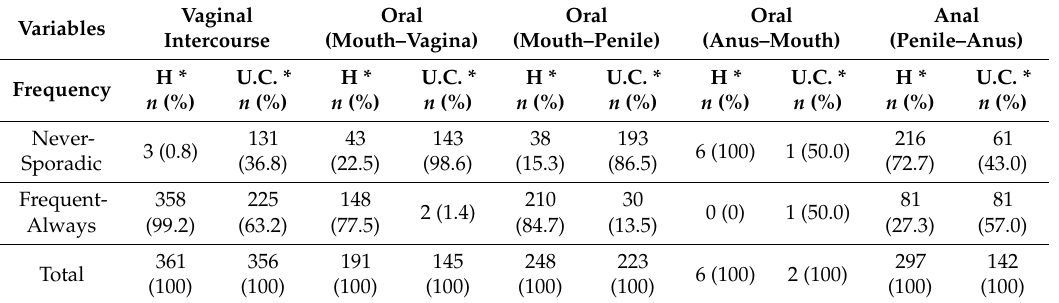
Table 2. Sexual habits and condom use.